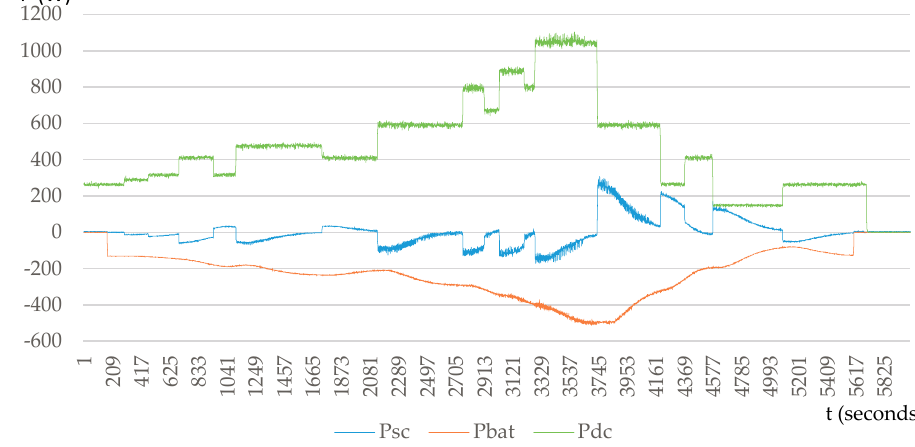
Figure 21. Graphics of the first experiment: damping ratio ζ = 0.1.